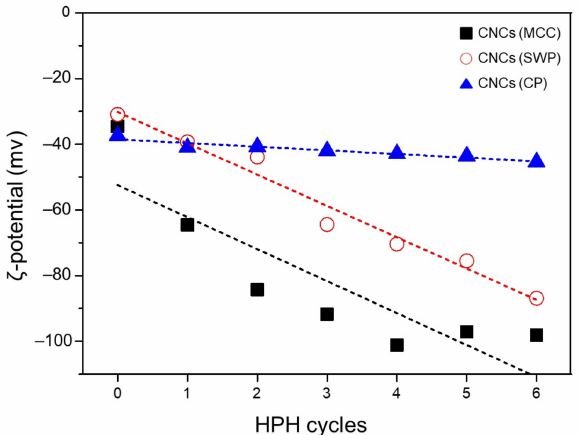
Figure 5. Zeta potential of CNCs from various materials (squares: CNCs (MCC) of 1.0 wt %; circles: CNCs (SWP) of 0.5 wt %; triangles: CNCs(CP) of 1.0 wt